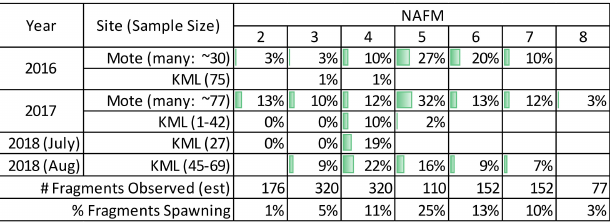
Each row includes the sample size of how many fragments were observed, but in two instances, the exact number was unknown, and values were assumed based on records from the adjacent nights. The bottom two rows sum the number of fragments observed on each night across all years (with estimates for the unknown nights included) and also the percentage of those fragments that spawned on each